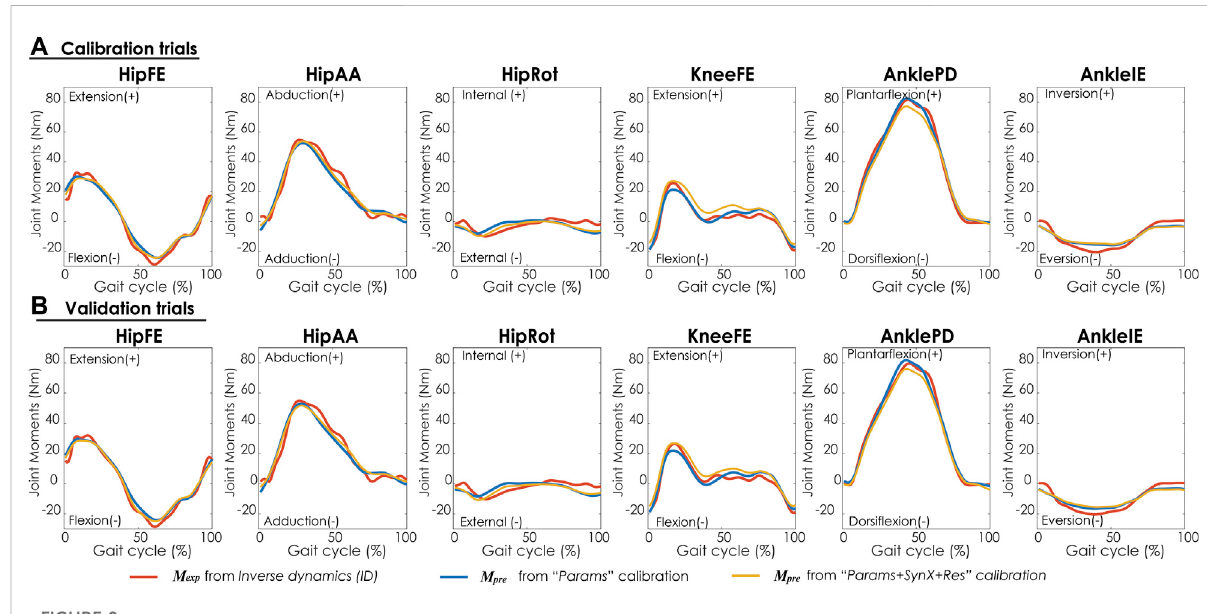
FIGURE 9 Average joint moments across trials and subjects for (A) calibration trials and (B) validation trials from inverse dynamics (in red), “ Params ” calibration (in blue), and “ Params + SynX + Res ” calibration (in yellow). Results for “ Params + SynX + Res ” calibration were produced using the best methodological combinations for generating computationally predicted walking motions (speed-speci fi c unmeasured and residual synergy vector weights with six synergies). Here, residual excitations were calibrated but not used to calculate joint moments for “ Params + SynX + Res. ” Data are reported for the complete gait cycle, where 0% indicates initial heel-strike and 100% indicates subsequent